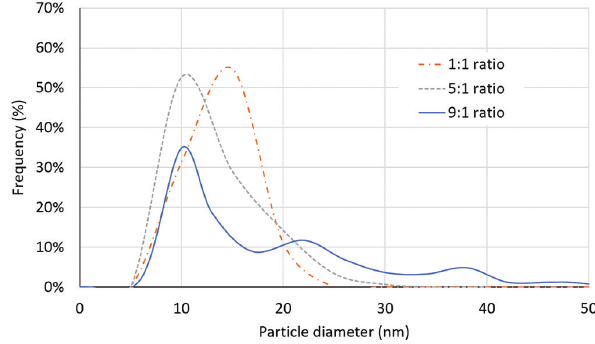
Figure 11: PSD developed from TEM images in Figure 10, showing effect of antisolvent to solvent ratio at 18 mL/s and 1200